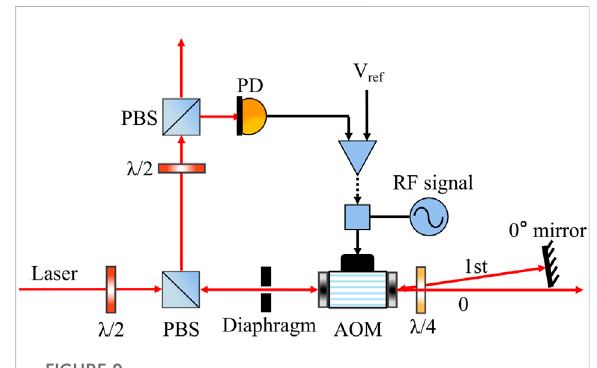
FIGURE 9 The scheme of stabilizing the laser power with an